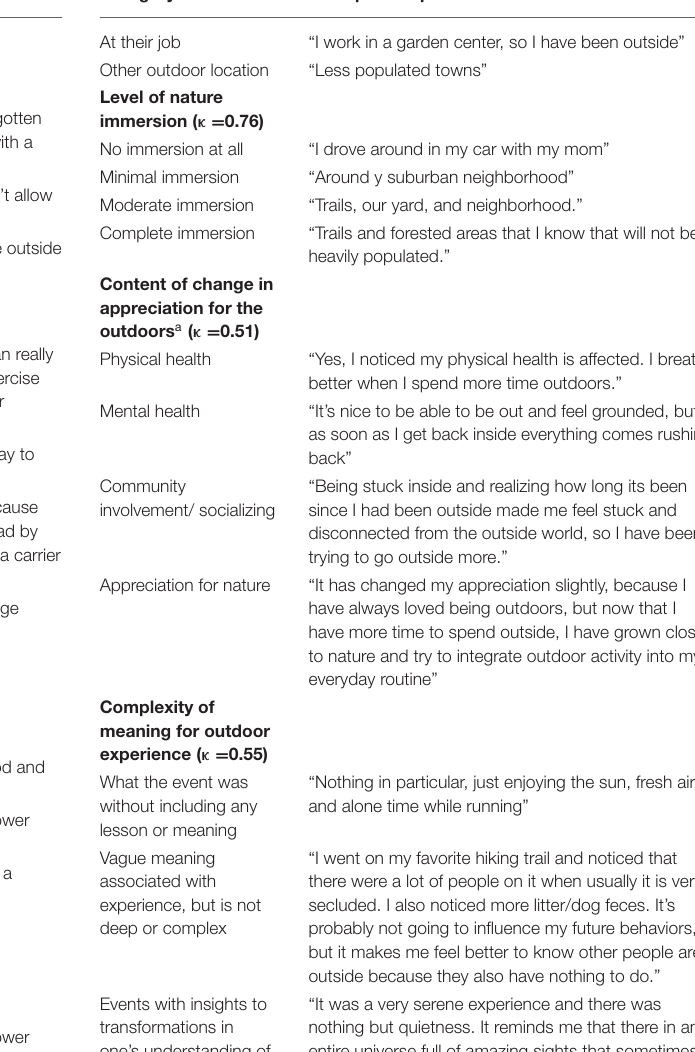
TABLE 2 | Qualitative coding categories and example responses. Category Examples